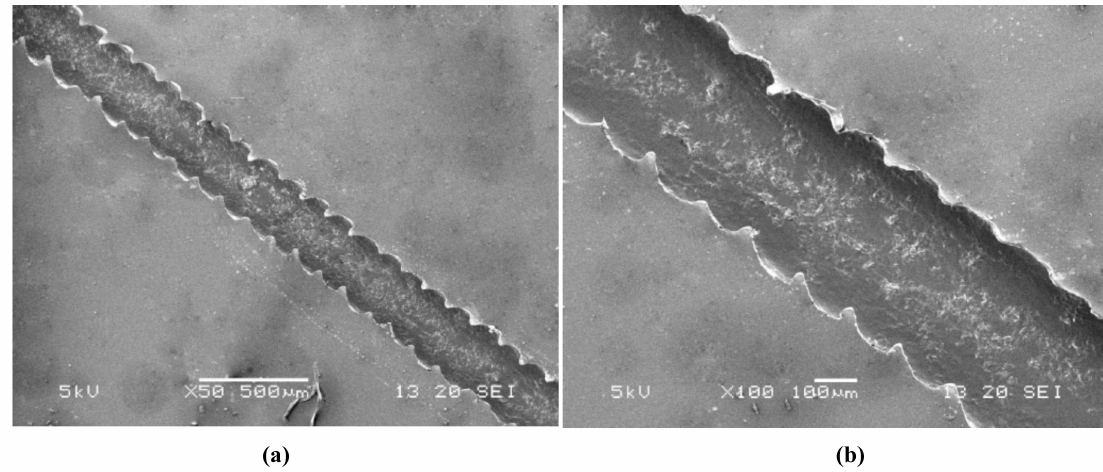
Figure 10. SEM photo of the straight area of the PDMS